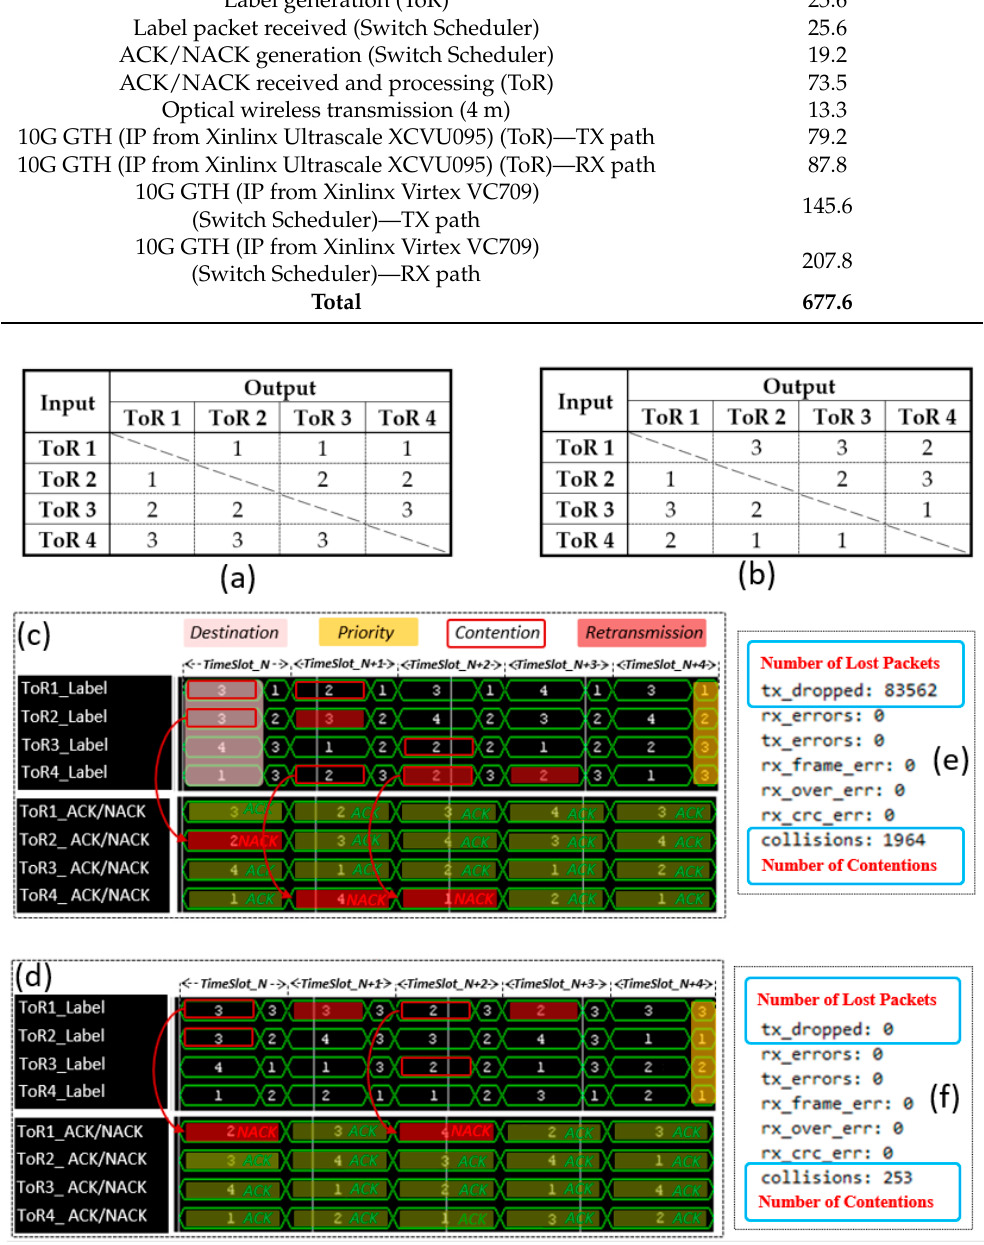
Figure 5. ( a ) The initial look ‐ up table of priority information; ( b ) The updated look ‐ up table of pri ‐ ority information; ( c ) The time traces at the FPGA ‐ based switch scheduler before